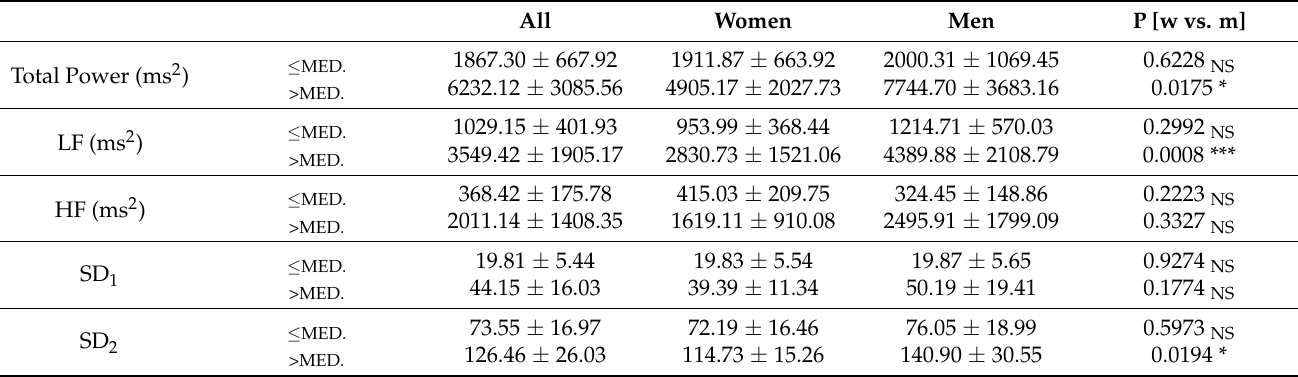
Table 6. Analysis of heart rate variability—HRV in the frequency domain for groups divided by the